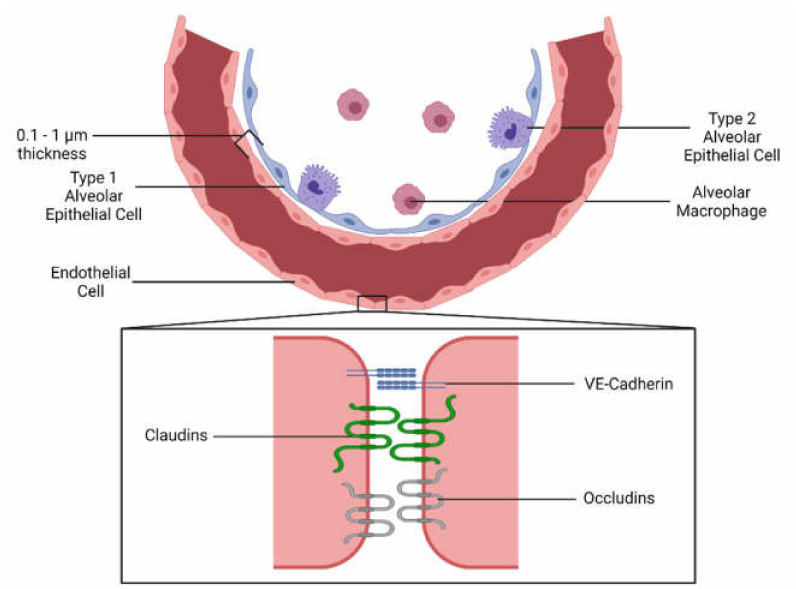
Figure 1. Anatomy of the alveolus. The alveolus is the basic functional unit of the lung. An extremely thin alveolar wall allows for gas exchange between air and blood. The outer layer is composed of pulmonary epithelial cells (also known as pneumocytes), of which there are two types. Type I epithelial cells permit gas exchange, while type II epithelial cells produce pulmonary surfactant. Pulmonary endothelial cells form the inner layer of the wall and line the pulmonary microvasculature. Endothelial cells form a continuous layer formed through tight and adherens cellular junctions between neighboring cells, thus preventing fluid leakage out of the lung. Vascular endothelial cadherin (VE-cadherin), claudins, and occludins form these junctions through homophilic and/or heterophilic interactions, restricting junction width to 2–5 nm. Created with